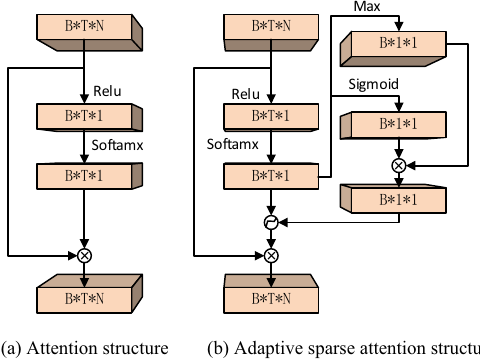
Figure 2. The change of adaptive sparse attention